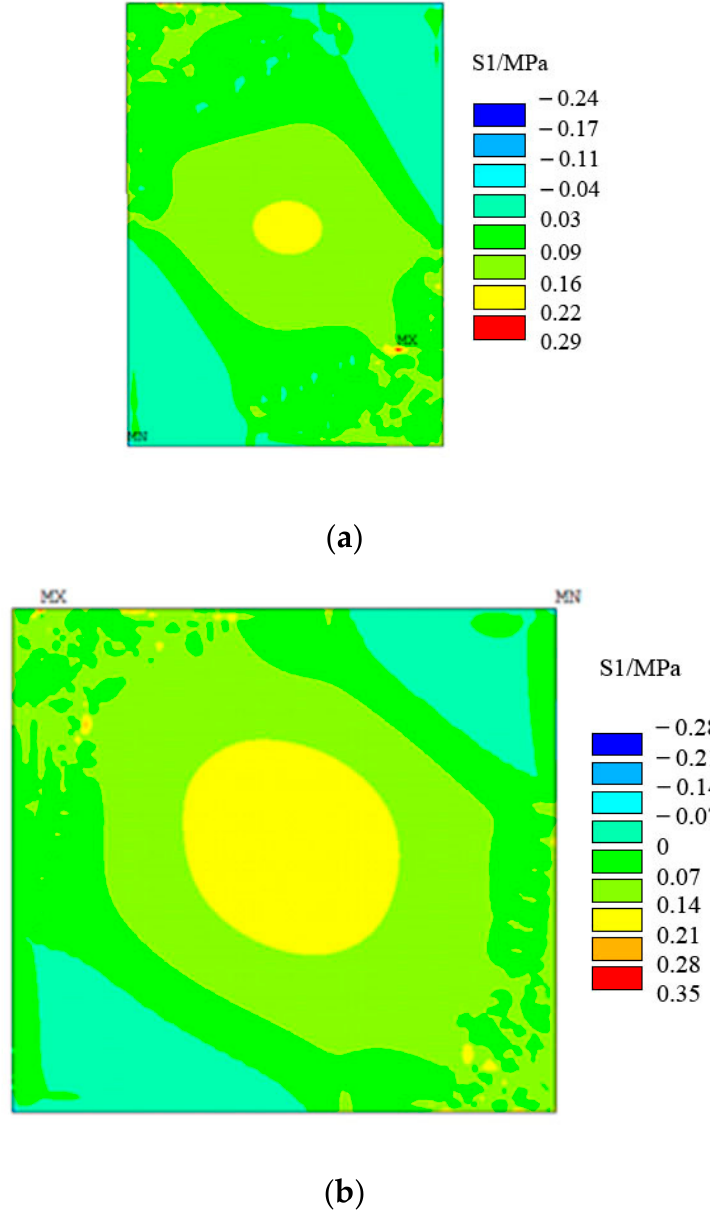
Figure 10. Maximum principal stress cloud diagram: ( a ) specimen W1 and ( b ) specimen W2.